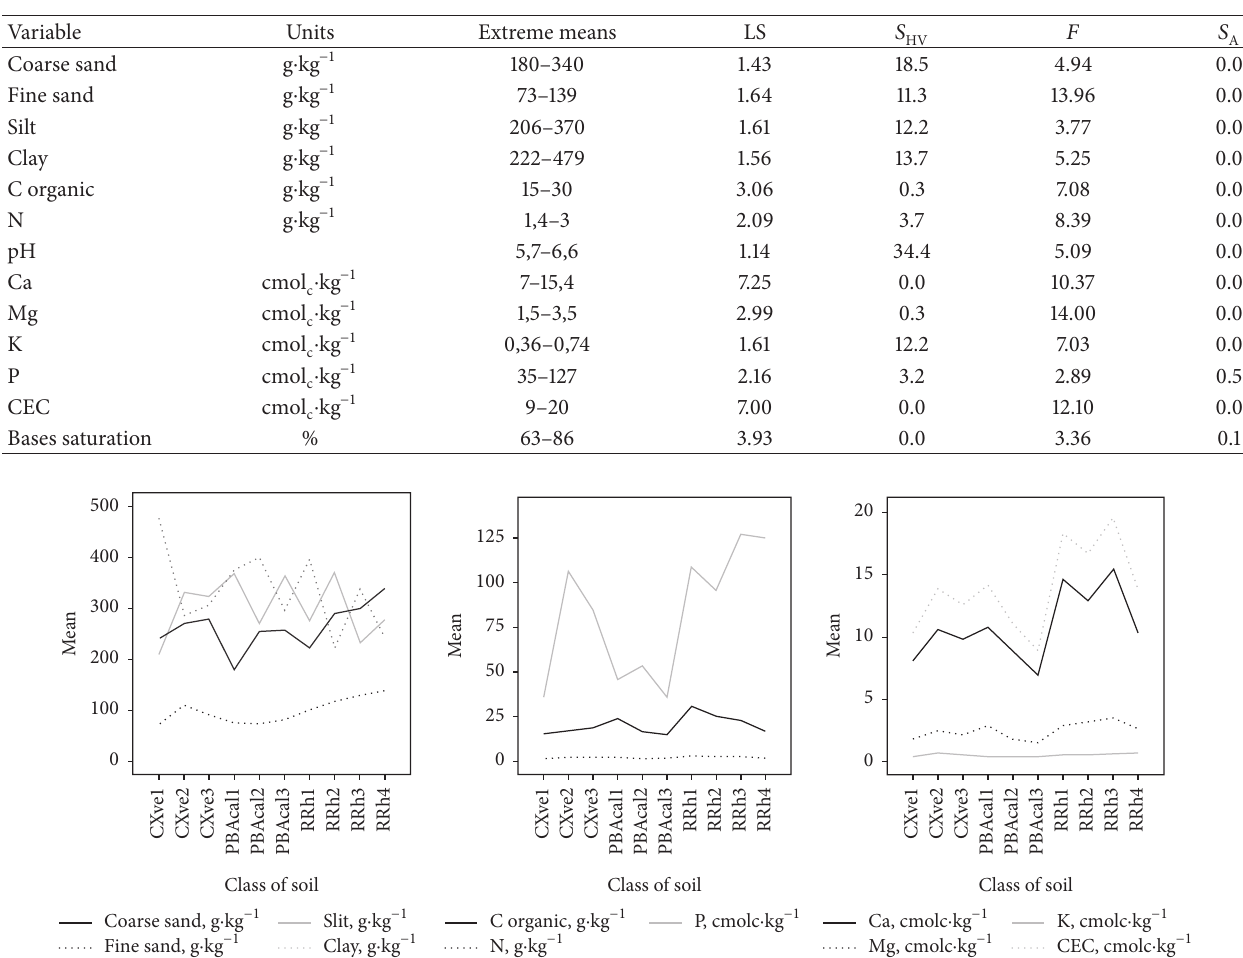
Table 4: Results of ANOVA as a factor of soil classes. LS = Levene statistic; 𝑆 = significance of 𝐹 statistic, % (ANOVA). Number of samples for the classes of soils and total: CXve1, CXve2, CXve3, PBAcal1, PBAcal2, PBAcal3, RRh1, RRh2, RRh3, and RRh4 and total equal to 8, 10, 22, 6, 15, 7, 11, 4, 8, 17, and 108, respectively.